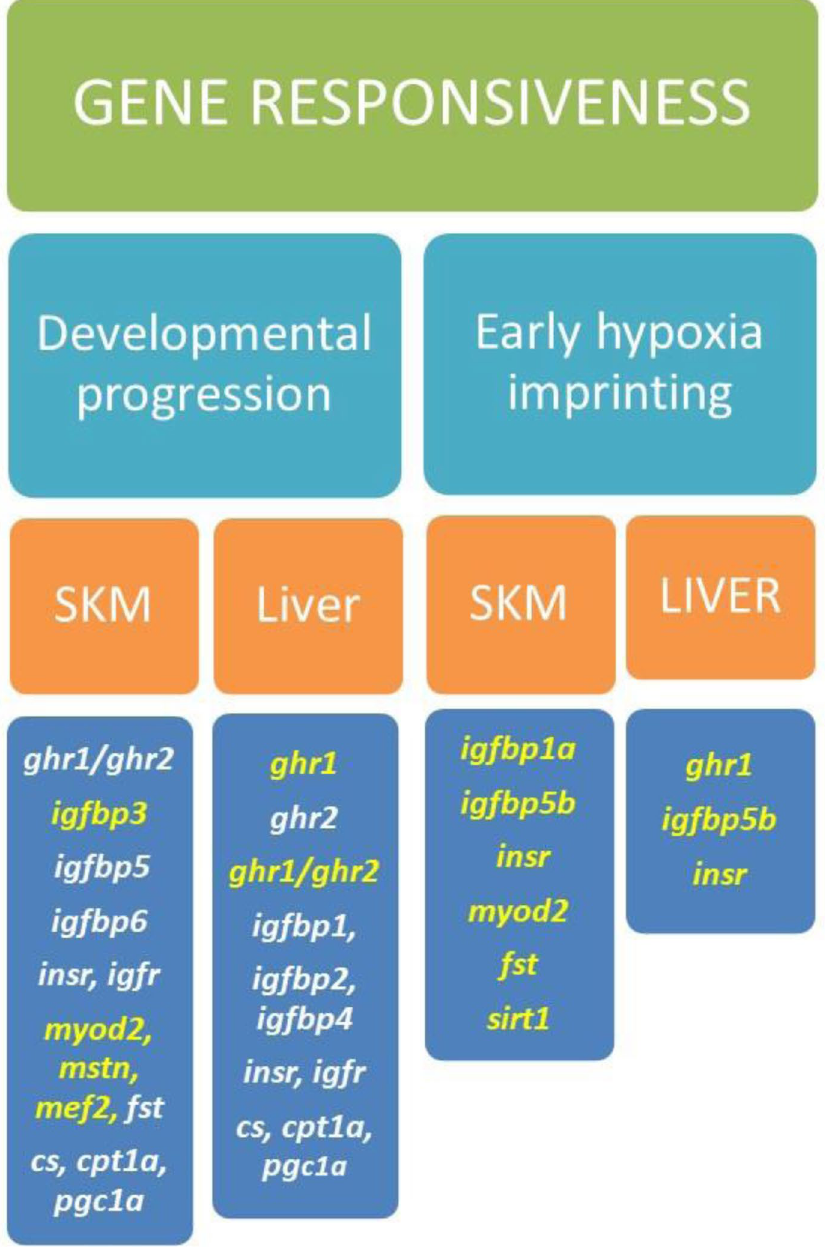
Figure 3. Schematic summary of progression of gilthead sea bream marker genes expression profiling in skeletal muscle and liver through development and as a response to early hypoxia. Genes with increased expression are highlighted in yellow, and those with decreased expression are highlighted in